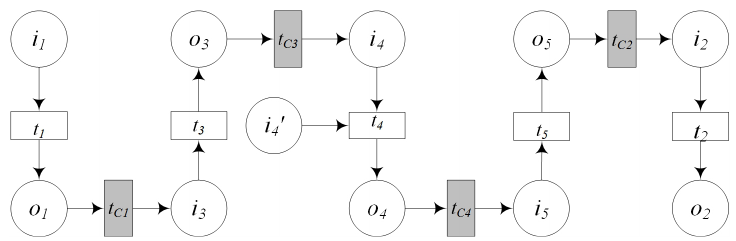
Figure 24. CPN model of lake water pollution